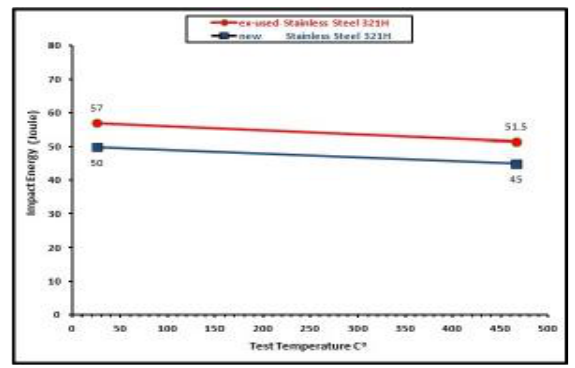
Fig. 5. Relation between impact energy and test temperature for austenitic stainless steel 321H.